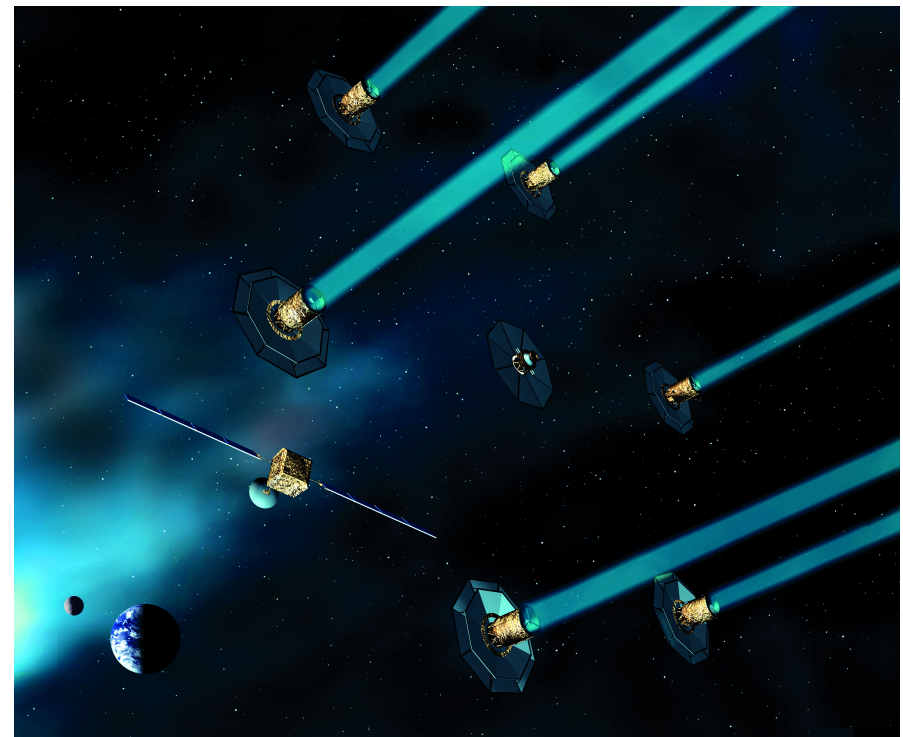
Figure 10. Artificial drawing of ESA’s Darwin mission study. (Image: ESA/Darwin, 2002, http://www.esa.int/spaceinimages/Images/2002/11/Darwin_will_combine_light_from_four_or_